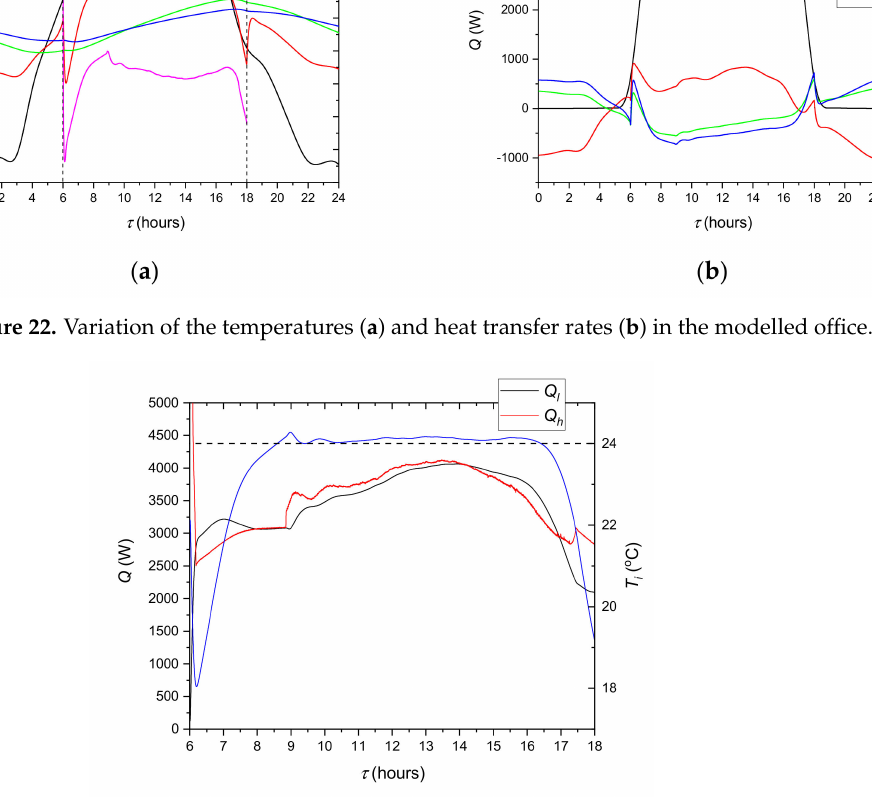
Figure 23. Variation of the indoor temperature T i (blue line), heat loads Q l and heat transfer rate Q h from cooling system. The dashed line indicates the set temperature in the